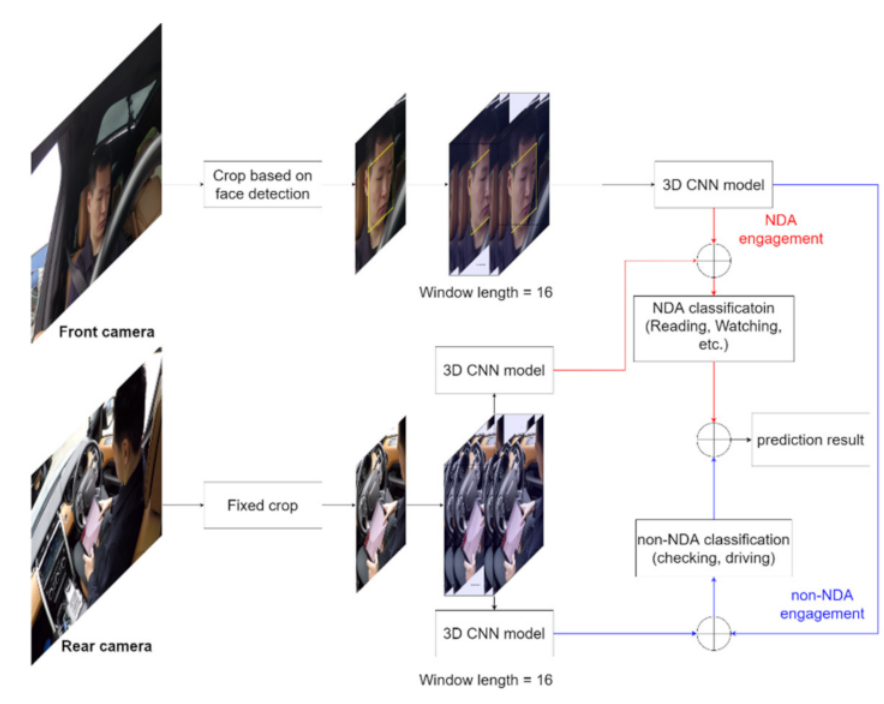
Figure 1. The proposed 2-feed NDA recognition